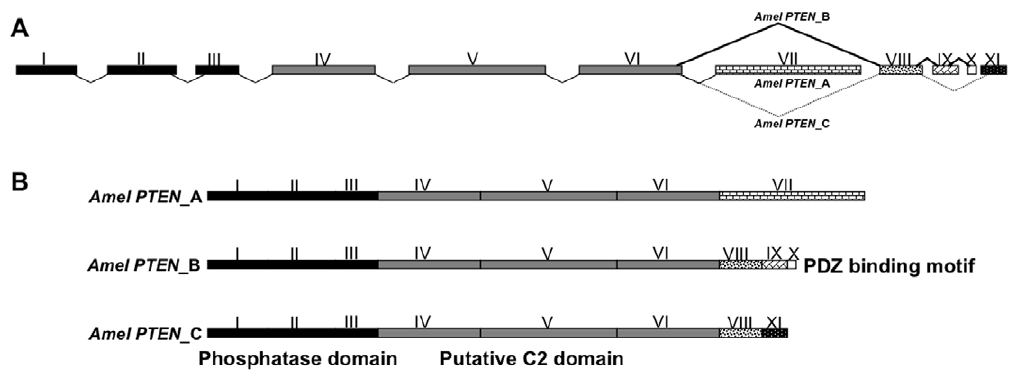
Figure 1. Schematic diagram of the organization of the honey bee PTEN gene. (A) cDNA sequences of three honey bee PTEN isoforms (A, B and C) were compared to the genomic sequences gleaned from the Honey Bee Genome Resources database (http://www.ncbi.nlm.nih.gov/genome/ seq/BlastGen/BlastGen.cgi?taxid=7460) to define the exons (including alternative exons) and introns. (B) Three alternate splice forms were cloned and their structure is